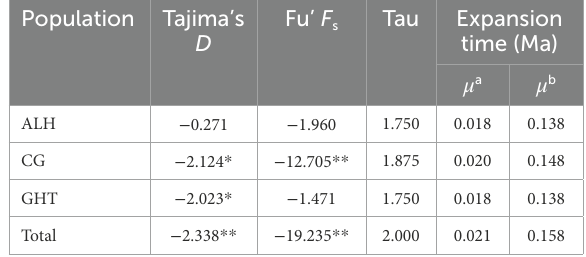
Two mutation rates of mtDNA CR in passerine birds are used for estimation of expansion time. μ a , Mutation rate, 8.72 × 10 − 8 ; μ b , Mutation rate, 1.156 × 10 − 8 ; * Statistical significance, p < 0.05; ** Statistical significance, p < 0.01.